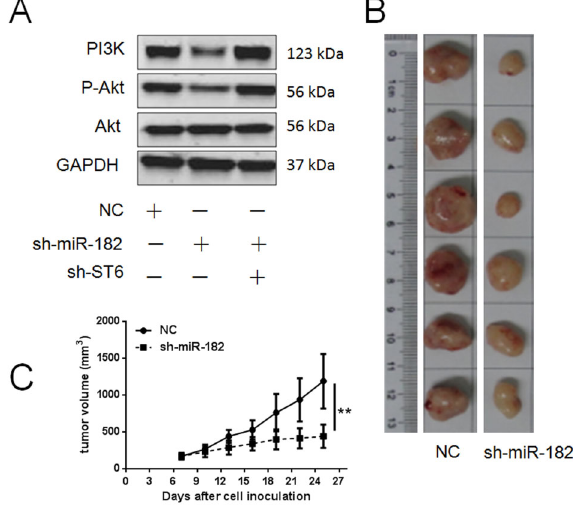
Figure 5. Knockdown of miR-182 inhibited tumorigenesis of PC3 cells. A , Western blot assay was used to detect key factors in PI3K/Akt pathway. B , Image of tumor formation in the negative control (NC) group and the sh-miR-182group in NOD/SCID mice. C , The average tumor volume in the sh-miR-182 group was smaller than in the NC group. Data are reported as means ± SD. **P o 0.01 (one-way